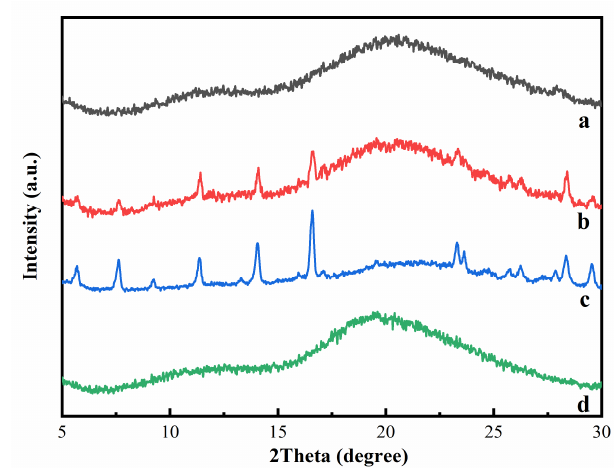
Figure 4. X-ray diffraction (XRD) patterns of HP-β-CD: myricetin inclusion complex ( a ), HP-β-CD: myricetin physical mixture ( b ), myricetin ( c ), and HP-β-CD ( d ).